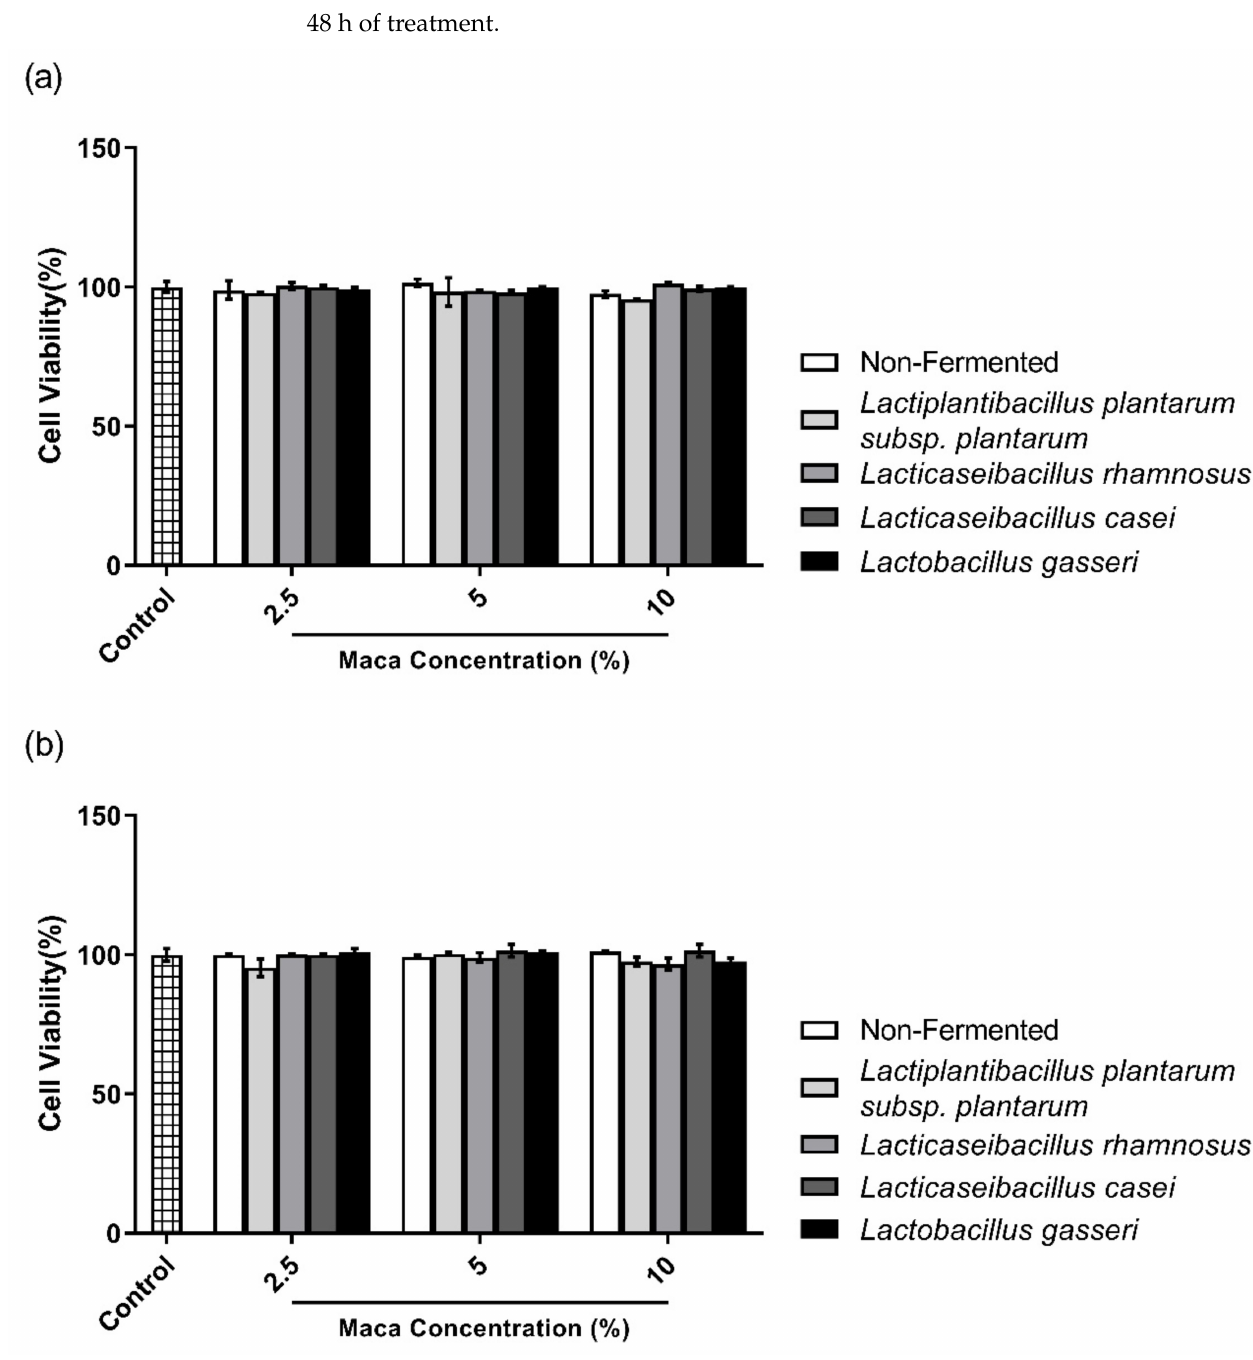
Figure 6. Cell viability of non-fermented and fermented maca root extracts on the B16F10 cell line. CCK-8 was used to confirm the non-fermented and fermented maca root extracts’ effects on the cell viability of B16F10 when treated for ( a ) 24 h and ( b ) 48